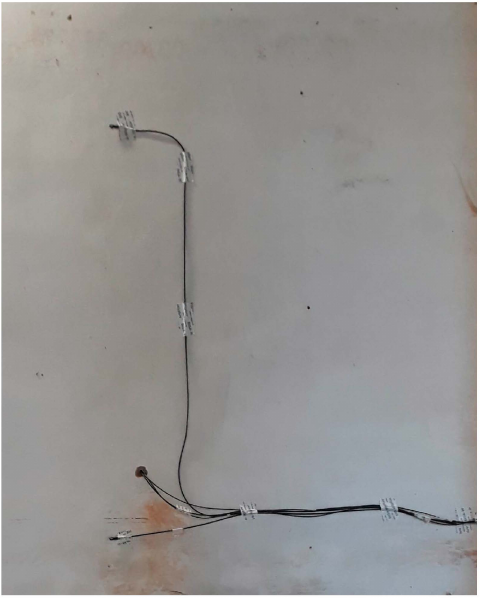
Figure 6. Tested wall and T-RH sensors location (photo by L. Dias